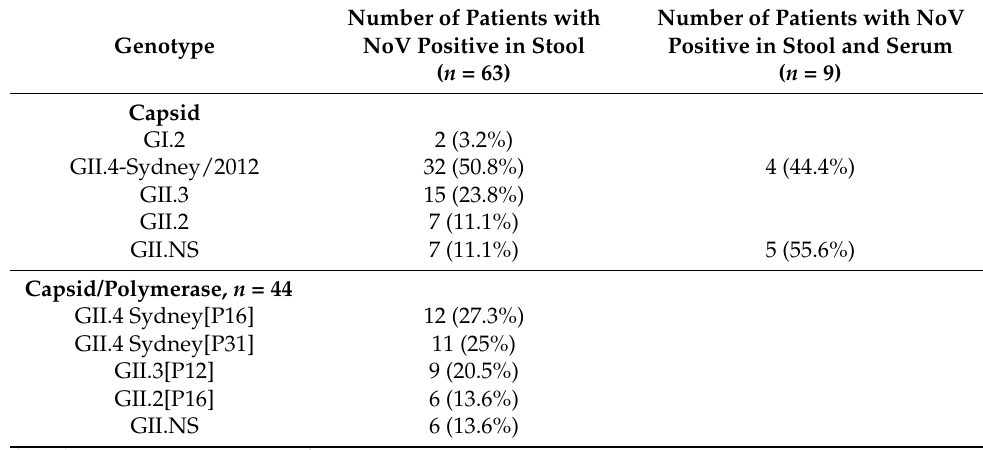
Table 2. NoV genotype distribution in infected